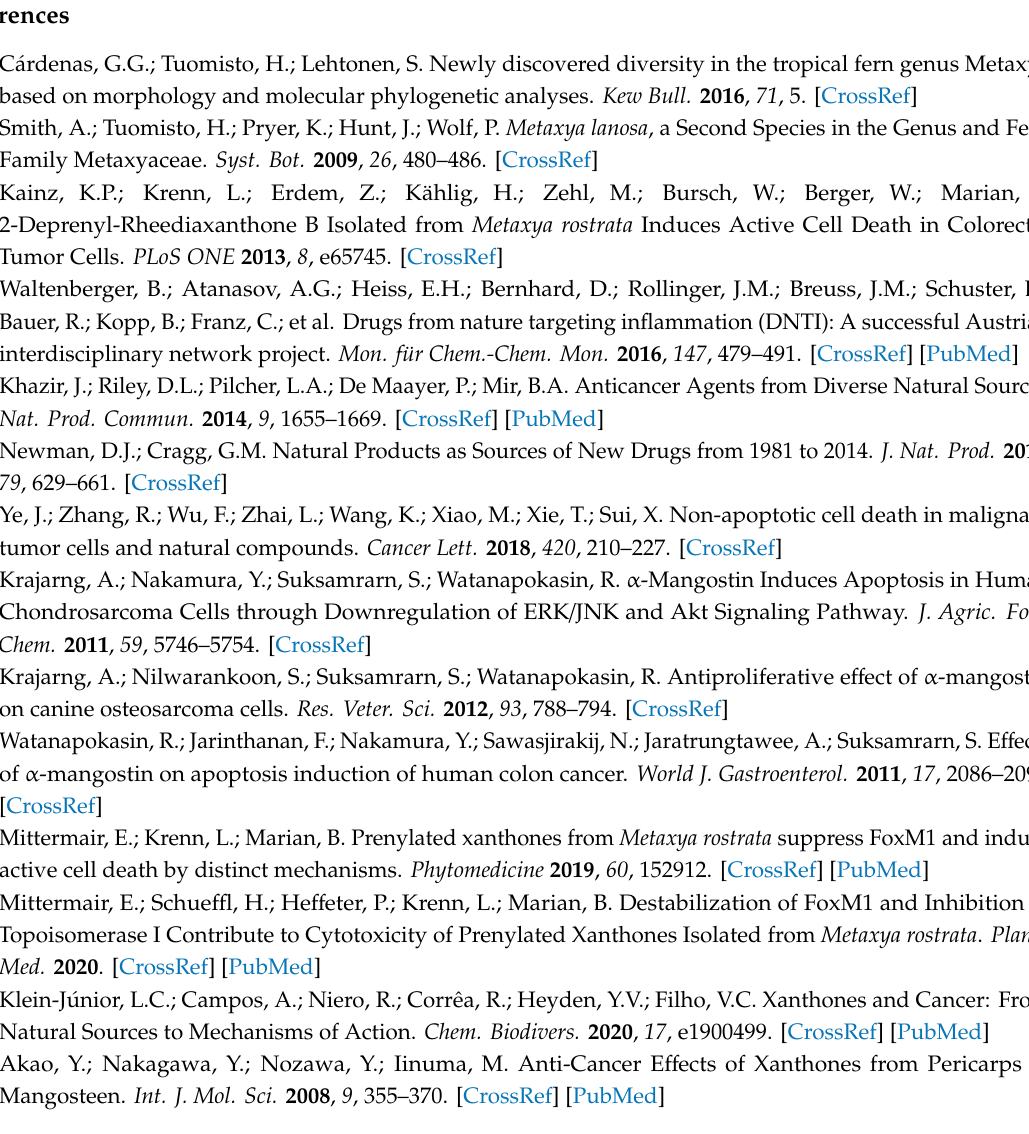
13 C-NMR spectrum of compound 2 1 H-NMR spectrum of compound 2 (CD 3 OD, 700.40 MHz), Figure S18: (CD 3 OD, 176.12 MHz), Figure S19: HSQC spectrum of compound 2 (CD 3 OD), Figure S20: HMBC spectrum of compound 2 (CD 3 OD), Figure S21: NOESY spectrum of compound 2 (CD 3 OD), Figure S22: MS1 spectrum of compound 2 showing the adduct [M + H] + , Figure S23: MS1 spectrum of compound 2 showing the adduct [M − H] − , Figure S24: MS2 spectrum of compound 2 fragmented using HCD at 55.0 eV, Figure S25: 1 H-NMR spectrum of compound 3 (CD 3 OD, 700.40 MHz), Figure S26: HSQC spectrum of compound 3 (CD 3 OD), Figure S27: HMBC spectrum of compound 3 (CD 3 OD), Figure S28: NOESY spectrum of compound 3 (CD 3 OD), Figure S29: MS1 spectrum of compound 3 showing the adduct [M + H] + , Figure S30: MS1 spectrum of compound 3 showing the adduct [M − H] − , Figure S31: MS2 spectrum of compound 3 fragmented using HCD at 55.0